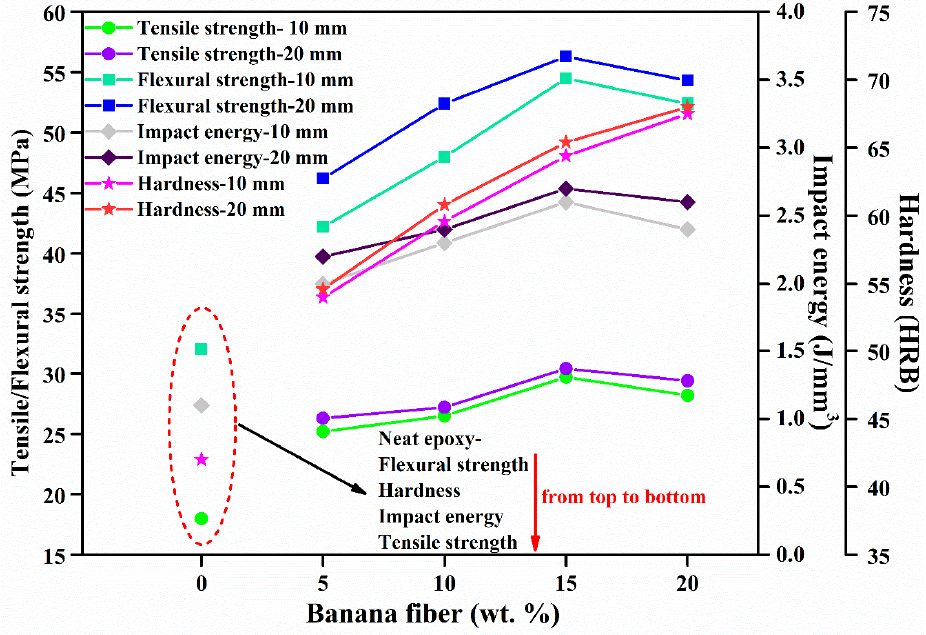
Figure 3. Effect of fiber loadings and length on the mechanical characteristics of the banana fiber- reinforced epoxy composites. reinforced epoxy